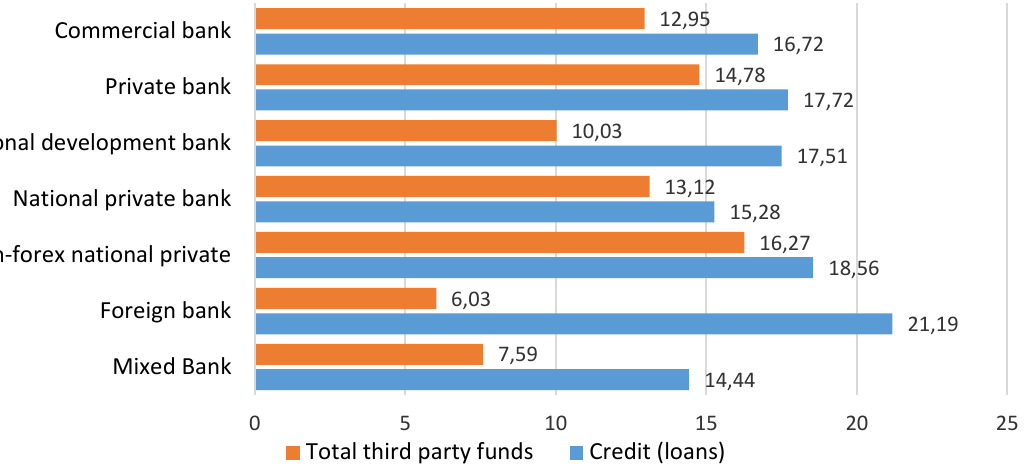
Figure 3. The growth of third party funds and loans